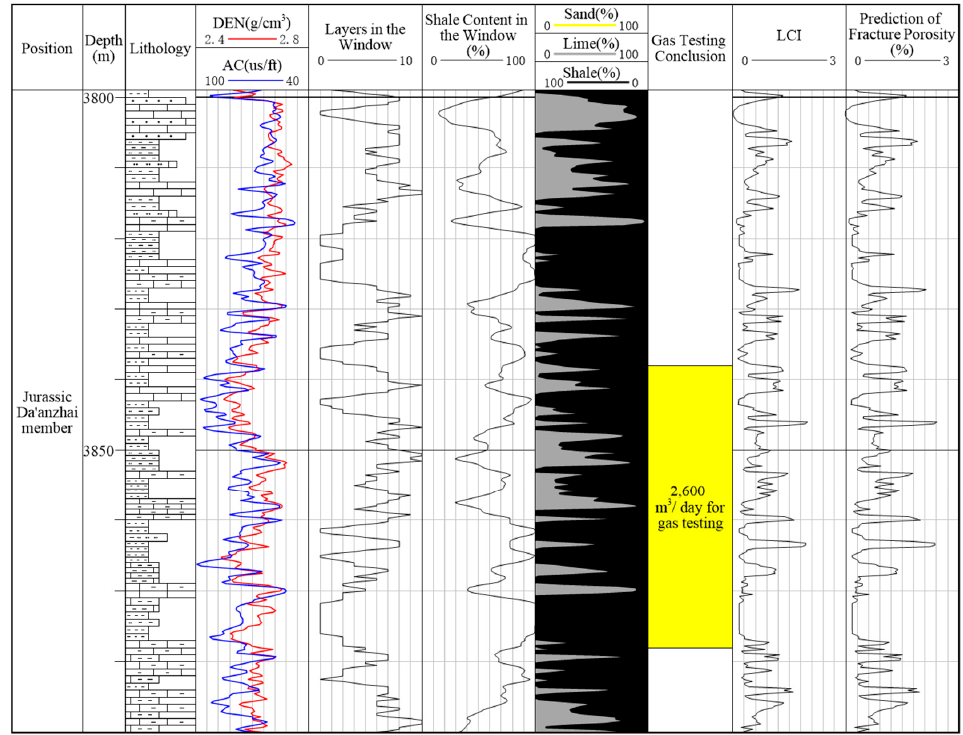
Figure A3. The prediction of fracture in Yuanba 11 well. Minerals 2020 , 10 , x FOR PEER REVIEW